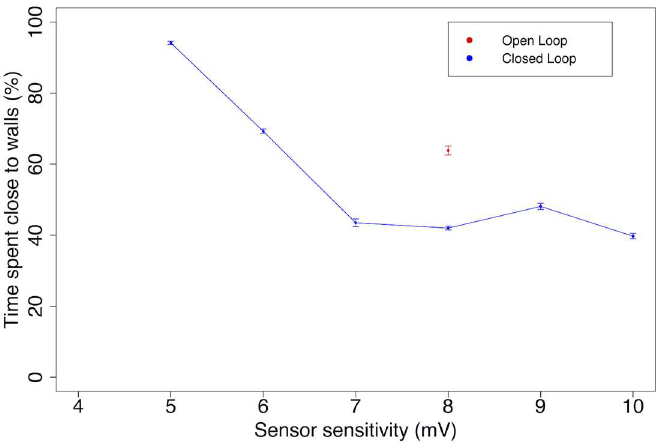
Fig 11. Learnability of wall avoidance based on sensor sensitivity. High numbers on the x axis indicate high sensitivity. Under 5 mV, the task cannot be learned;learnabilityimproves until 7 mV, leadingto the maximum performance of the robot. The open loop and closed loop results for the same sensitivity of 8 mV are reportedfrom Fig 10. We have omitted the open loop cases as they are insensitiveto the walls, but shown for the case at the sensor sensitivity = 8 mV. Statistical results for N = 20 networks with standard